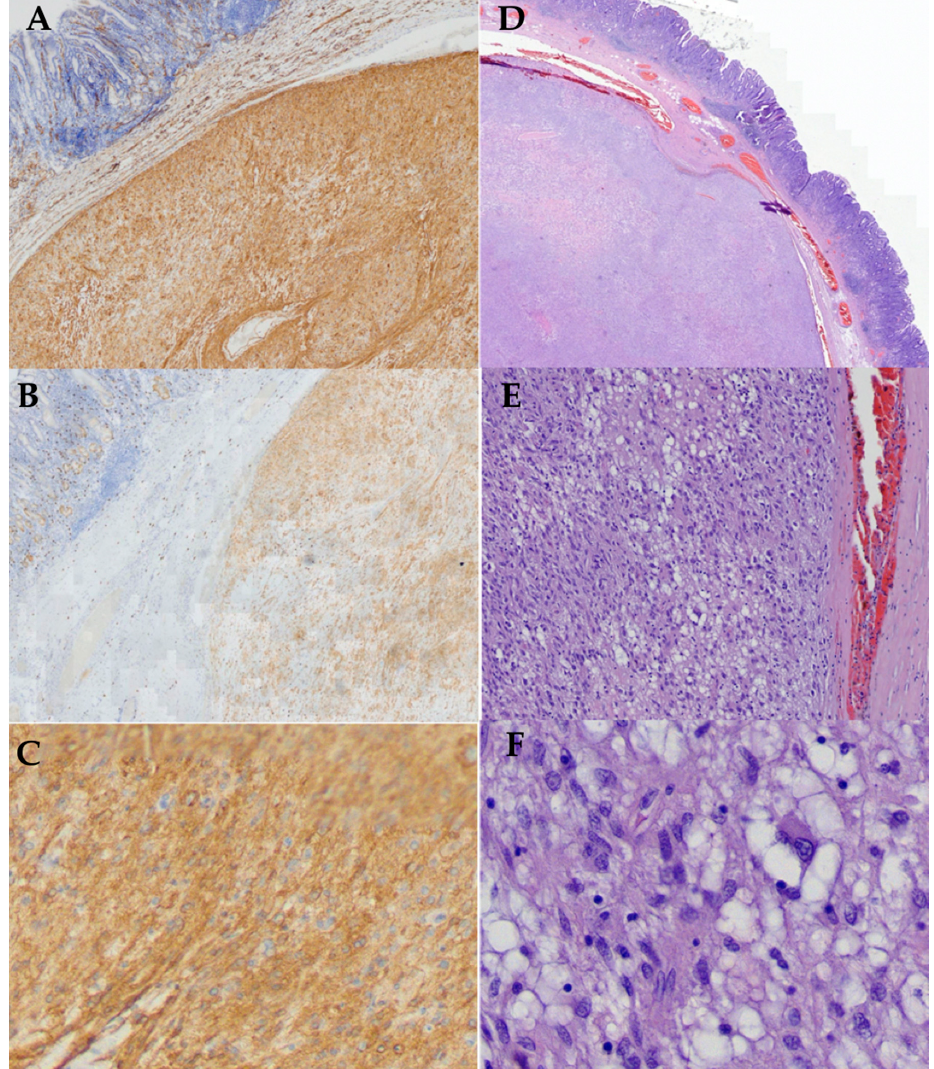
Figure 6. Immunohistochemical markers of the tumors. Membranous and cytoplasmic staining for ( A ) CD 117 ( + ), CD 34 ( + ), DOG-1 ( + ). (Case 1–4); ( B ) CD34 ( + ) strong positive (4 × ); ( C ) CD117 ( + ) mild positive ( × 4); ( D ) strong and di ff use expression of DOG1 ( + ), ( D) membranous and cytoplasmic (2 × ), ( E ) 10 × ; ( F ) 40 × H&E—mixed epithelioid / spindle cell morphology with subnuclear vacuoles, eosinophilic cytoplasm and abundant myxoid stroma with thin-walled blood